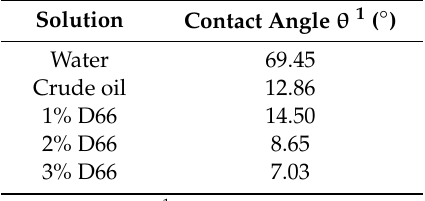
Table 9. Contact angle on Guelph Dolomite